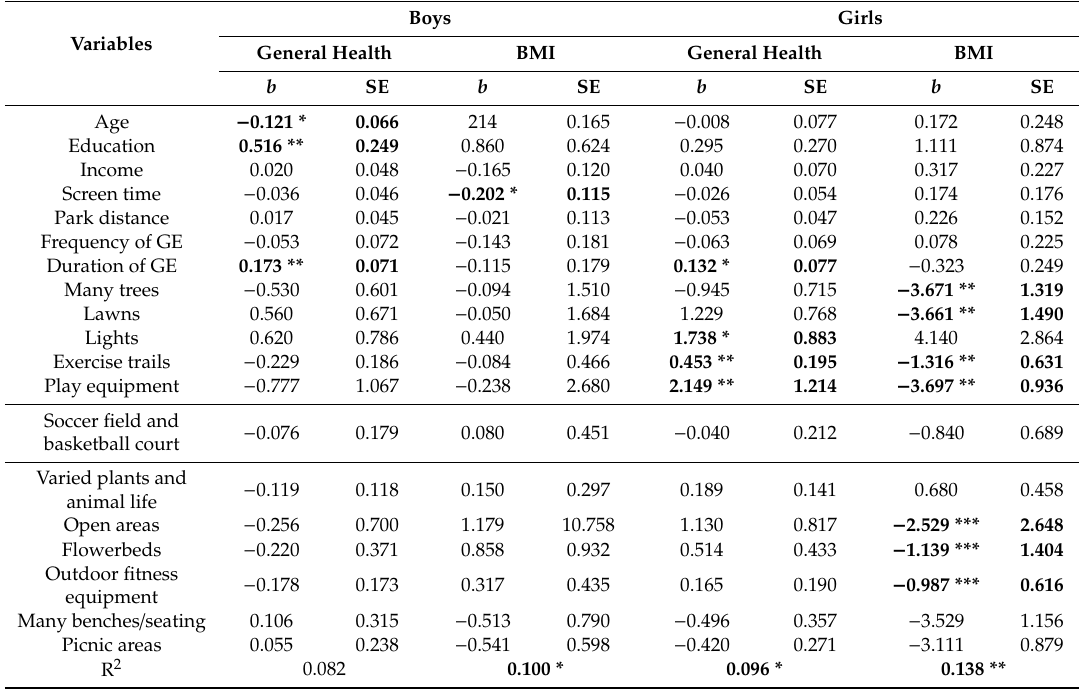
Table 5. Associations between characteristics of UGSs and adolescents’ self-reported general health and BMI, stratified by